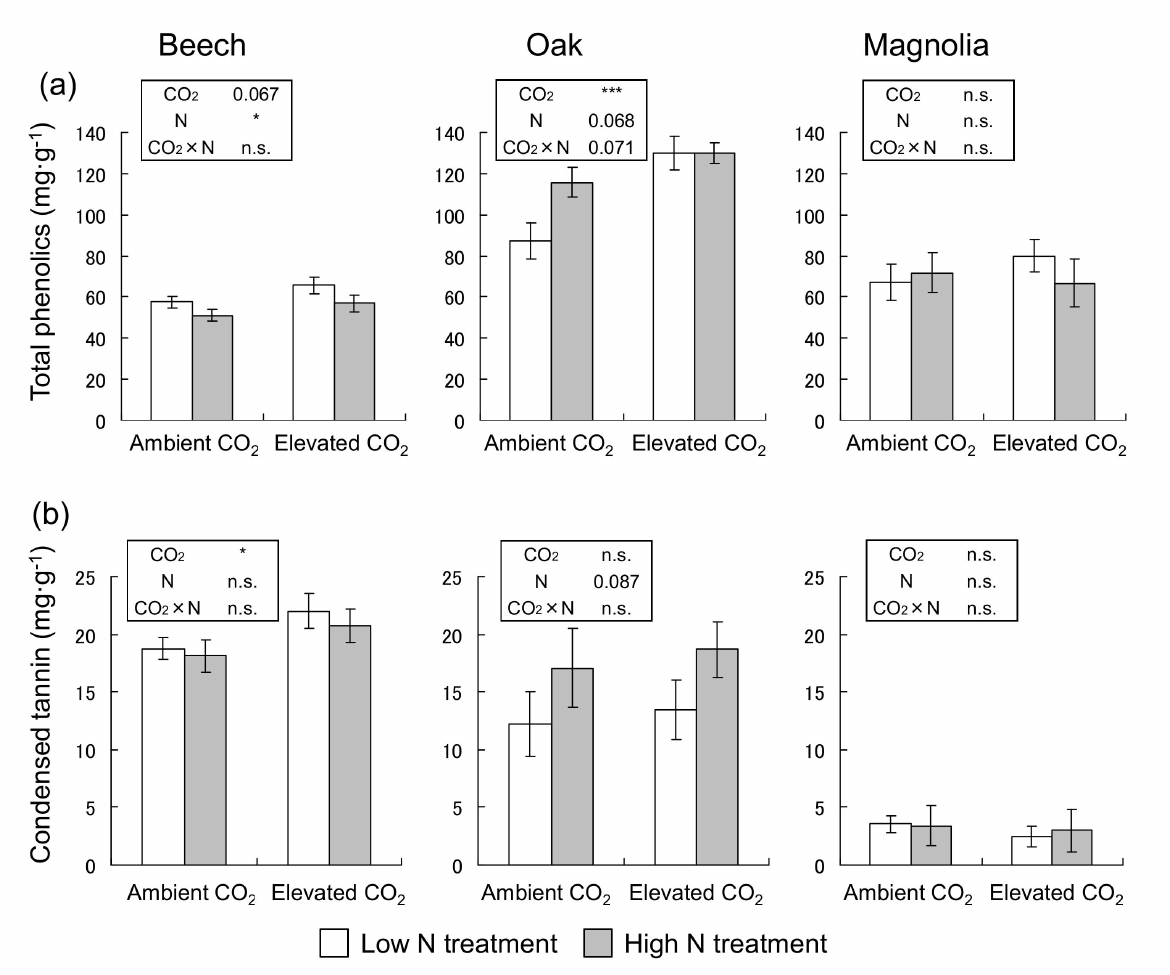
Figure 3. Concentrations of ( a ) total phenolics and ( b ) condensed tannin in the leaves of seedlings of three tree species at each treatment. Values are expressed as means ± SE (beech n = 12, oak and magnolia n = 6). The results of the two-way ANOVA are also shown (*** p < 0.001, * p < 0.05, n.s. p ≥ 0.1). Actual p values are shown when 0.05 < p < 0.10. n.s.; not